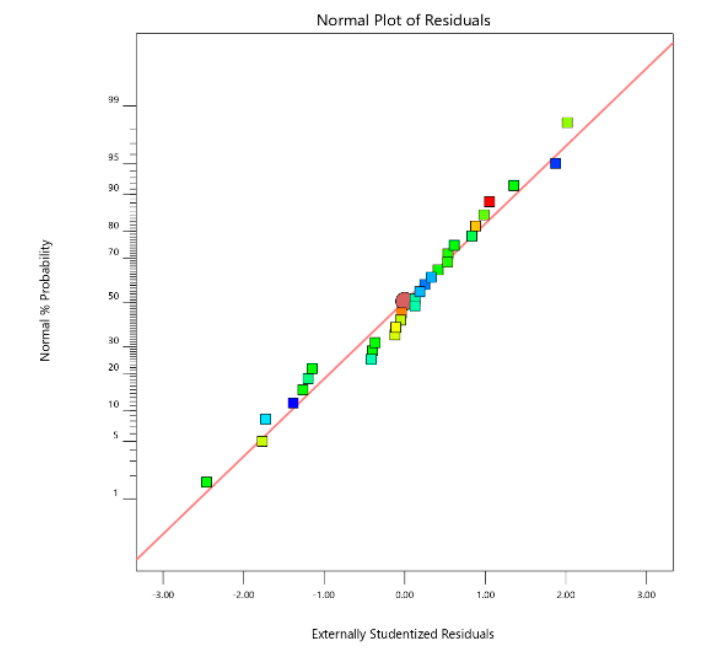
Figure 5. Normal probability plot of the internally studentized residuals for PNP removal.